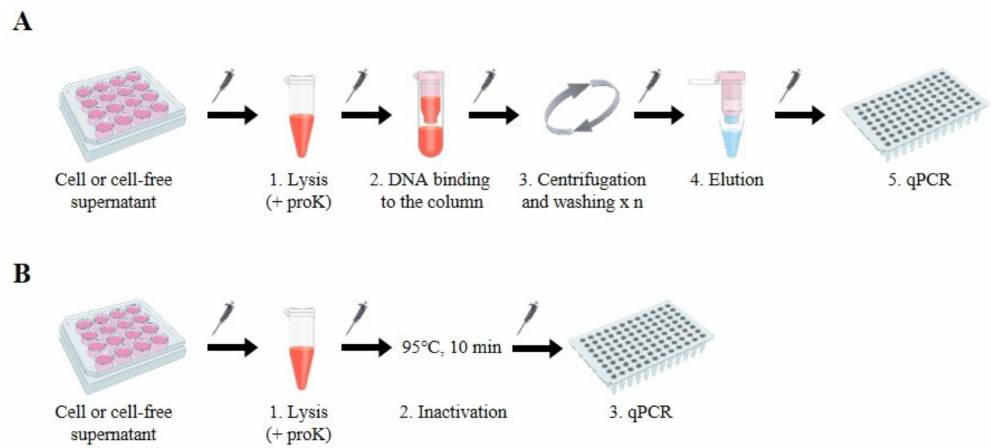
Figure 1. Schematic illustration of the HBV DNA preparation workflow for qPCR